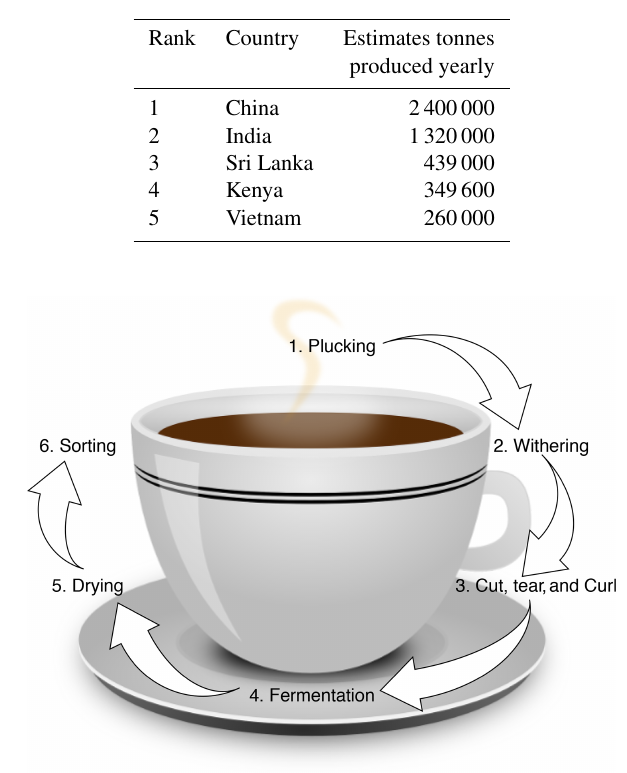
Table 1. The countries leading in tea production globally.